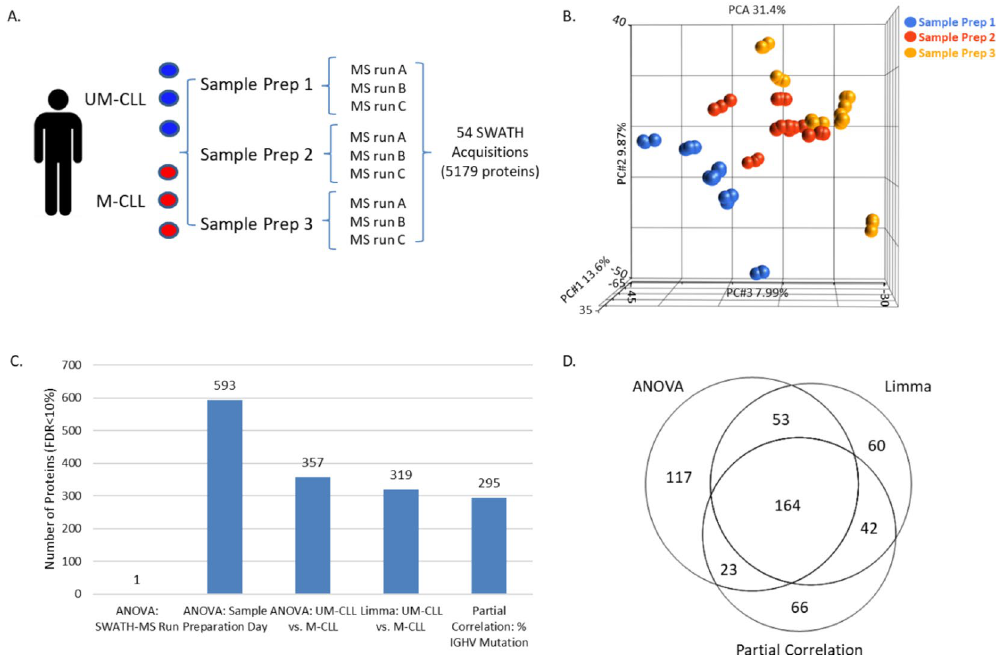
Figure 2. Identification of variation in SWATH-MS data associated with biological and technical factors. ( A ) Experimental design showing 6 CLL patients samples (3 UM-CLL and 3 M-CLL) with replicate sample preparations (n = 3), each analysed in triplicate by SWATH-MS, resulting in 54 acquisitions and quantitative information for 5179 proteins across all samples. ( B ) PCA plot of uncorrected protein expression data showing sample clustering based on sample preparation day. ( C ) Results of ANOVA, limma and partial correlation analysis, highlighting the number of differentially expressed proteins identified (≤ 10% FDR) which are associated with technical variables (SWATH-MS run and sample preparation day) or biological variables (IGHV mutational subgroup (UM-CLL/M-CLL) and % of IGHV mutation). ( D ) Venn diagram showing overlap of proteins found to be differentially expressed between UM-CLL and M-CLL by ANOVA and limma and proteins correlating with the percentage of IGHV mutation by partial correlation